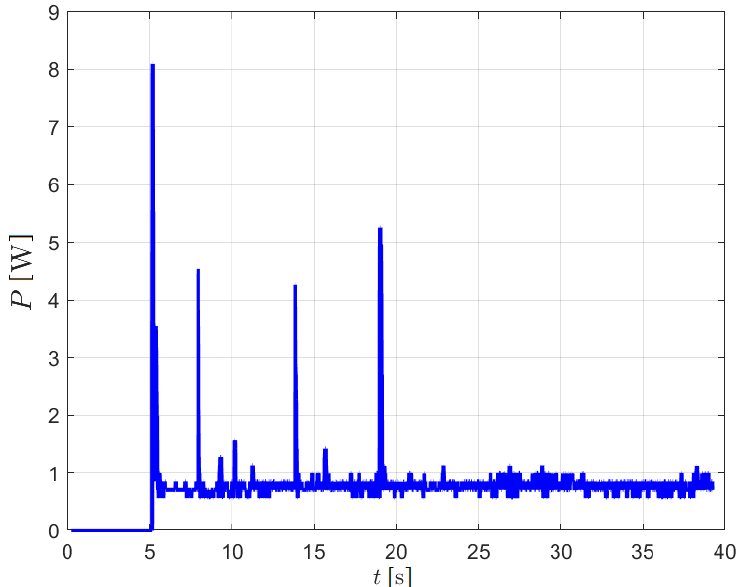
Figure 36. Power P during Map 1 run for the RRT algorithm of the